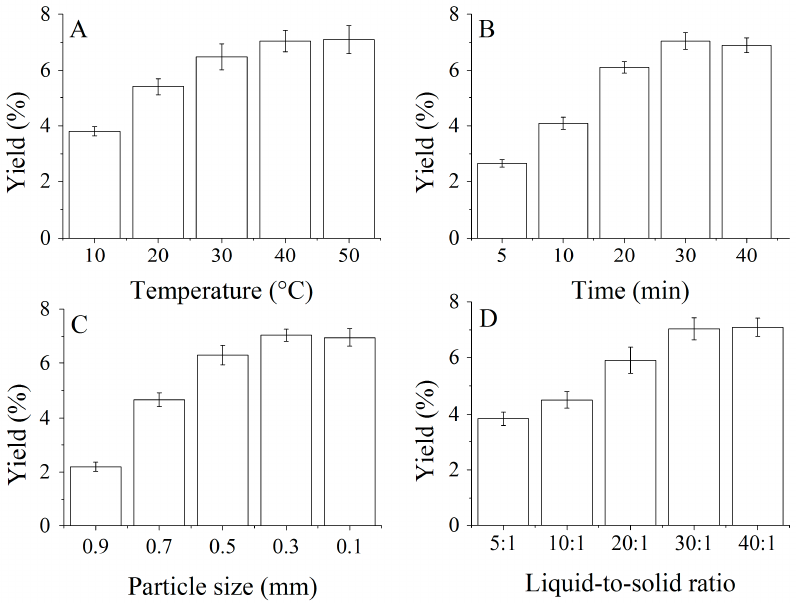
Figure 1. Effects of ( A ) extraction temperature; ( B ) extraction time; ( C ) raw material particle size and ( D ) liquid/solid ratio on the oil yield.